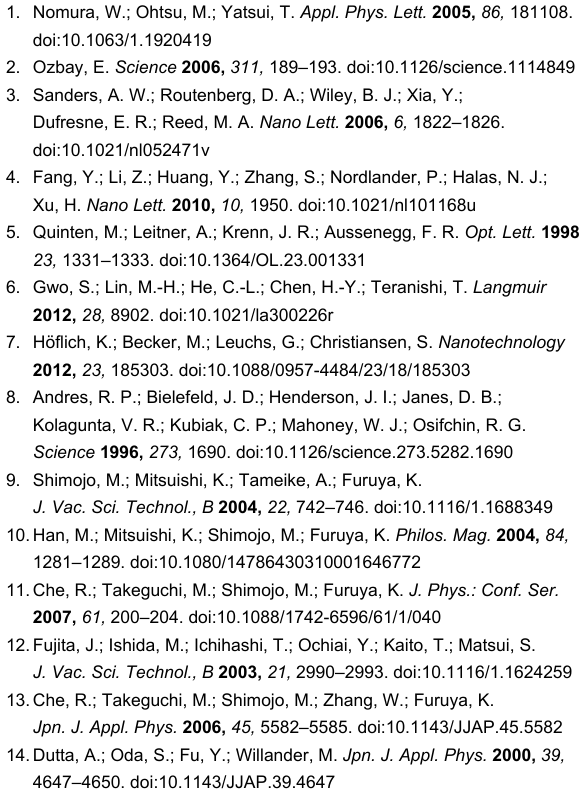
Step (i): the amino-undecanethiol